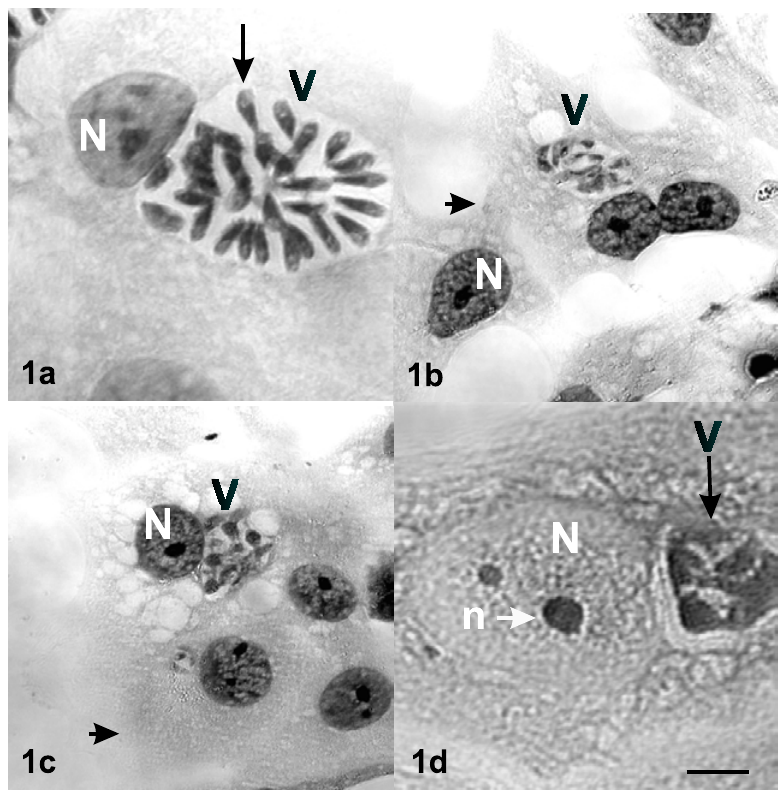
Fig. 1 – Giemsa-stained Vero cells infected with tachyzoites of T. gondii for 24h (fig. 1a). Parasites with crescent-shaped multiplies inside parasitophorous vacuole (V). During incubation for 12h (fig. 1b), 24h (fig. 1c) or 48h (fig. 1d) with hydroxyurea, tachyzoites had undergone drastic morphological alterations while host cell were not affected. Tachyzoytes: arrow; Host cell: arrowhead; Parasitophorous vacuole: V; Nucleus: N; Nucleolus: n. Bar: 7 µ